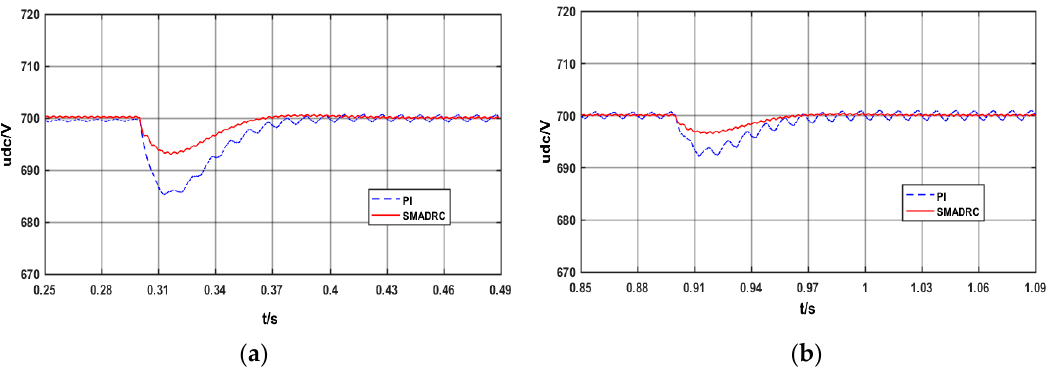
Figure 10. DC voltage during the load transients: ( a ) Resistance type load and ( b ) Constant power load. At 0.5 s, the photovoltaic is connected to the power grid and, at 0.7 s, the light intensity changes